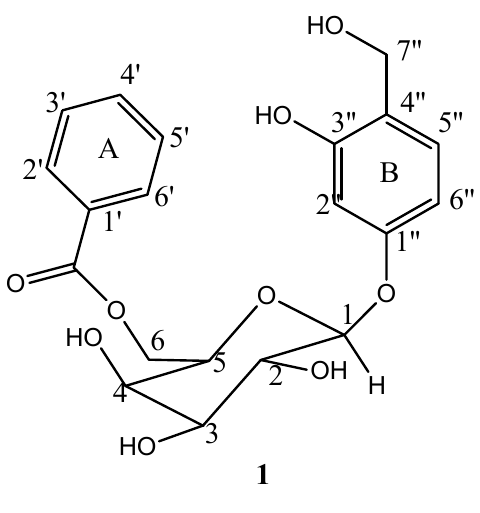
Figure 1. Flacourtin.